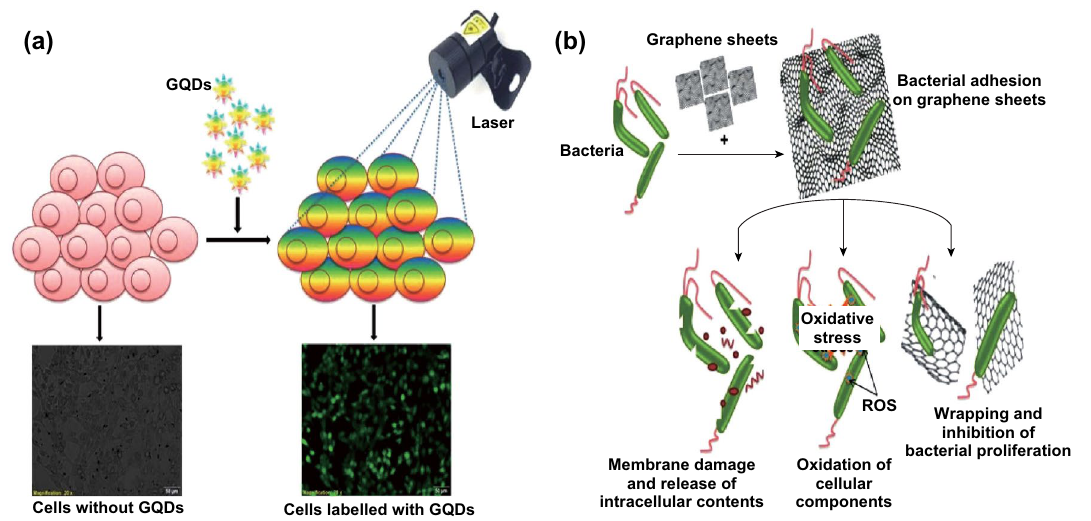
Fig. 5 Bioimaging application. a Graphene quantum dots for in vitro cellular imaging. b Mechanism of toxicity induced by graphene in bacte- rial